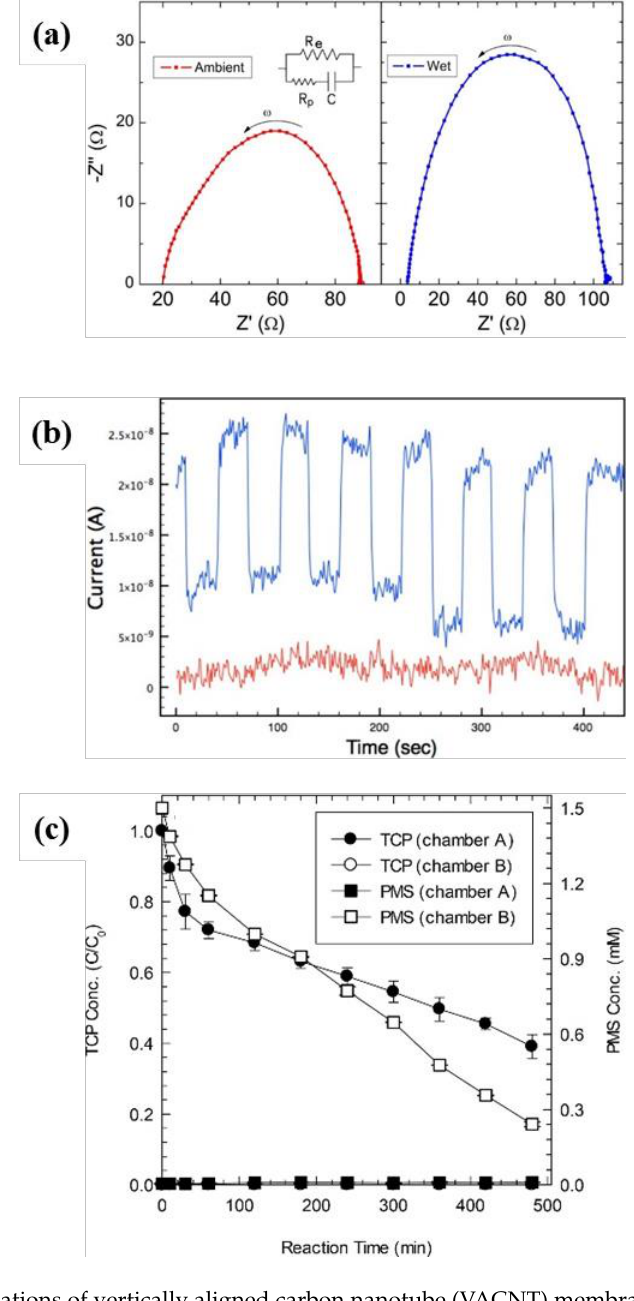
Figure 8. Applications of vertically aligned carbon nanotube (VACNT) membranes exploiting their electrical conductivity. ( a ) Nyquist plots of VACNT and Nafion membranes under ambient (left) and wet (right) conditions [93] . ( b ) Peak photocurrent generated in a VACNT membrane upon irradiation with 440 nm light (blue). Troughs occur when the light source is physically blocked, preventing irradiation. The red signal corresponds to the same experiment performed as a control on a VACNT membrane without quantum dots on the surface [77] . ( c ) Simultaneous 2,4,6-trichlorophenol (TCP) oxidation and peroxymonosulfate (PMS) reduction in the reaction system partitioned into two chambers by a VACNT membrane [129] .